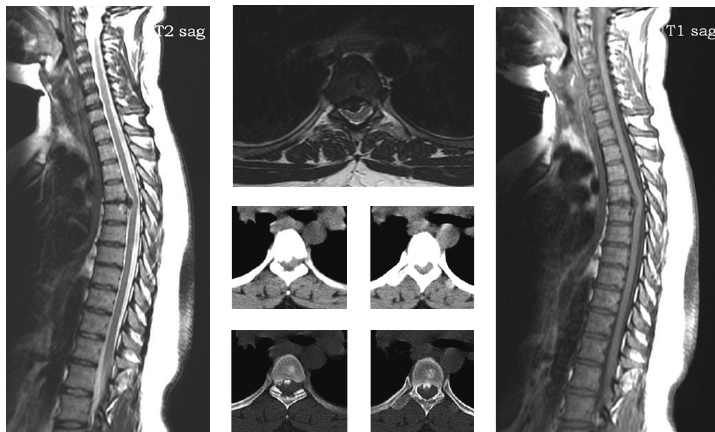
Figure 1: 35-year-old female. Back pain and also in both legs. Progressive weakness in lower extremities. Preoperative VAS was 5. In the neurological examination there was paraparesis in low extremities (Case 1). Preoperative views of the patient revealed a thoracic 4-5 disc herniation.